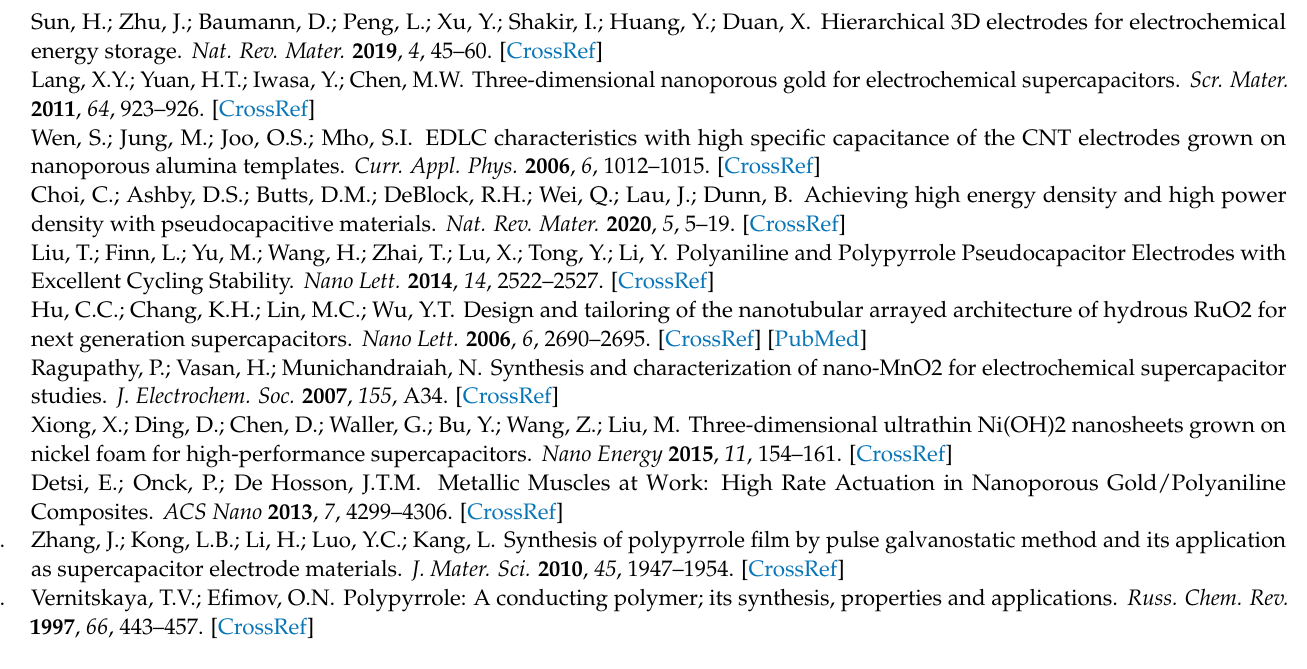
at different current densities; Figure S7: CV curves of NPG/PPy(10 nm) and NPG/PPy(30 nm) at 5 mV s − 1 ; Figure S8: Equivalent circuit for EIS